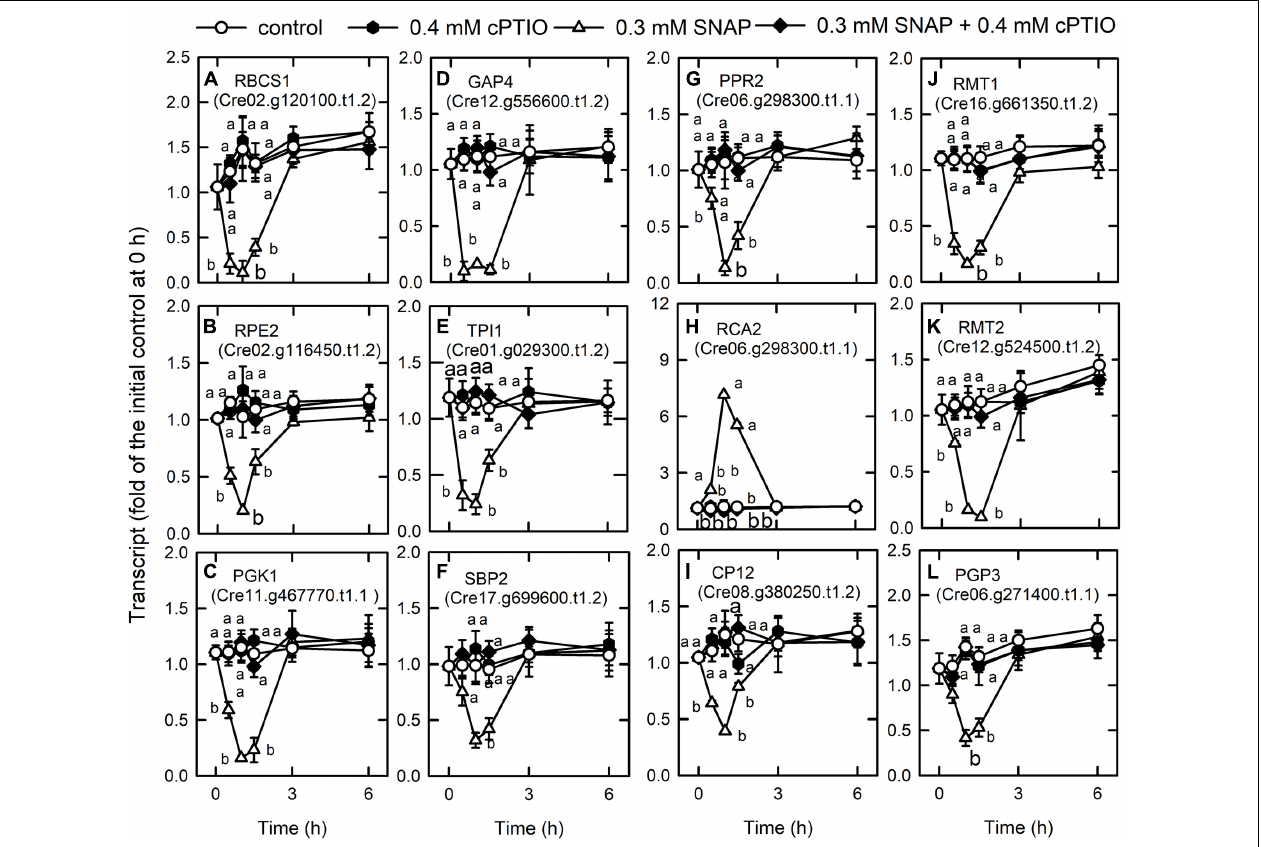
FIGURE 3 | Effects of NO on the expression of genes encoding Calvin cycle proteins. Time-course changes in the transcript abundances of RBCS1 (A) , RPE2 (B) , PGK1 (C) , GAP4 (D) , TPI1 (E) , SBP2 (F) , PPR2 (G) , RCA2 (H) , CP12 (I) , RMT1 (J) , RMT2 (K) , and PGP3 (L) in C. reinhardtii after exposure to 0.3 mM SNAP in the presence or absence of 0.4 mM cPTIO. Data are expressed as the mean ± SD ( n = 3). Different symbols indicate significant differences between treatments (Scheffe’s test, P < 0.05).